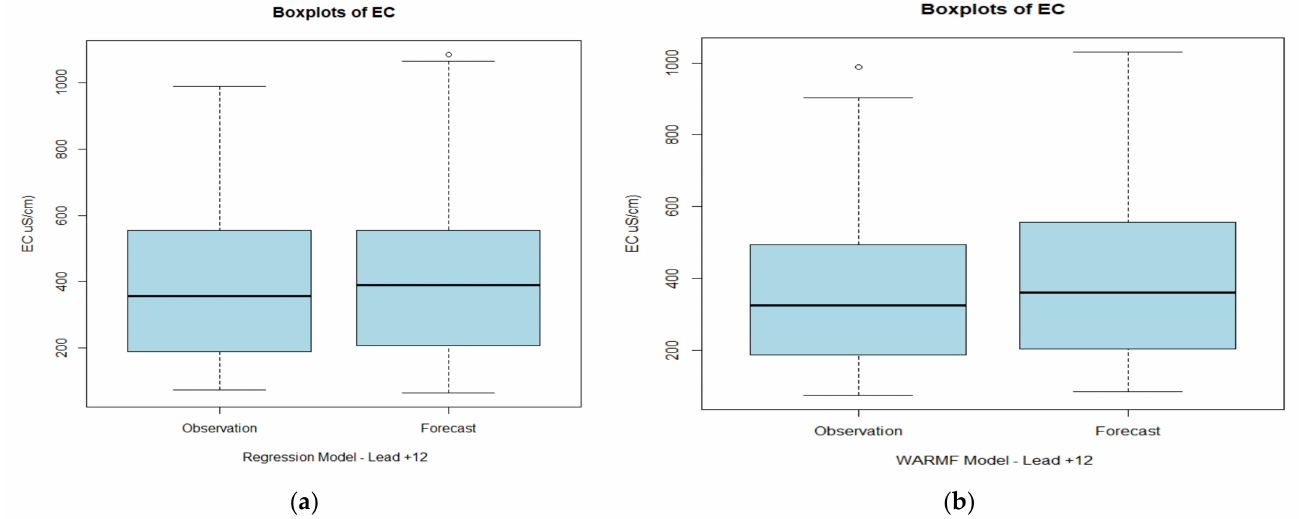
Figure 13. ( a , b ). Boxplots of observed EC and forecast EC by the Regression ( a ) and WARMF ( b ) models are shown for forecast lead time ∆ Day + 12. Fligner–Killeen variance p values are 0.6244 and 0.2703 for the Regression and WARMF models, respectively.